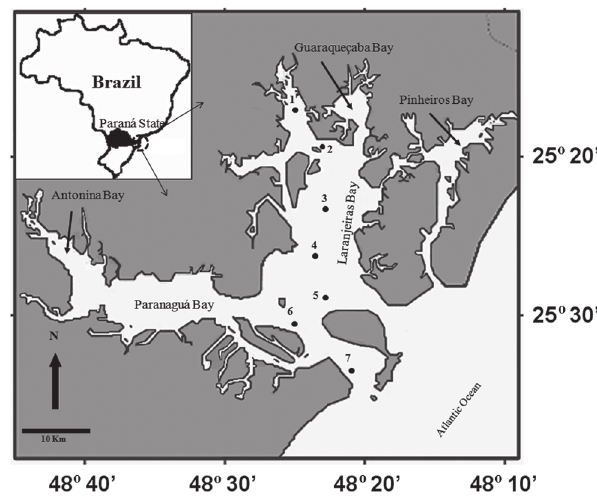
Fig. 1. Location of the sampling sites in the Paranaguá Estuarine Complex, Paraná State, subtropical region of